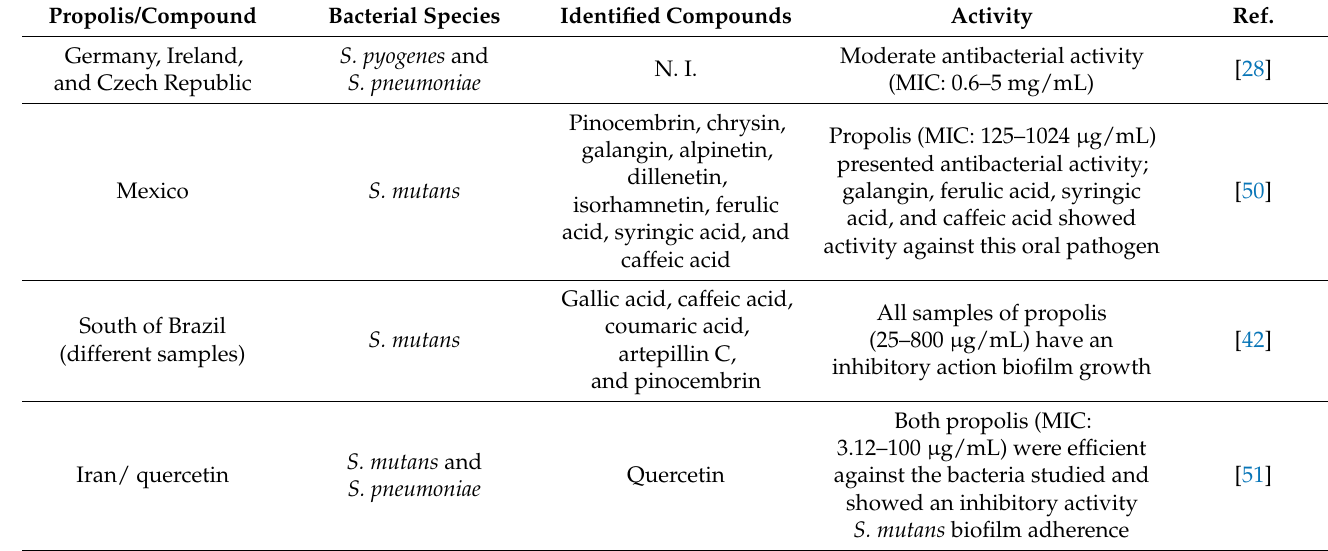
Table 4. Antistreptococcal activity of diverse propolis and its chemical